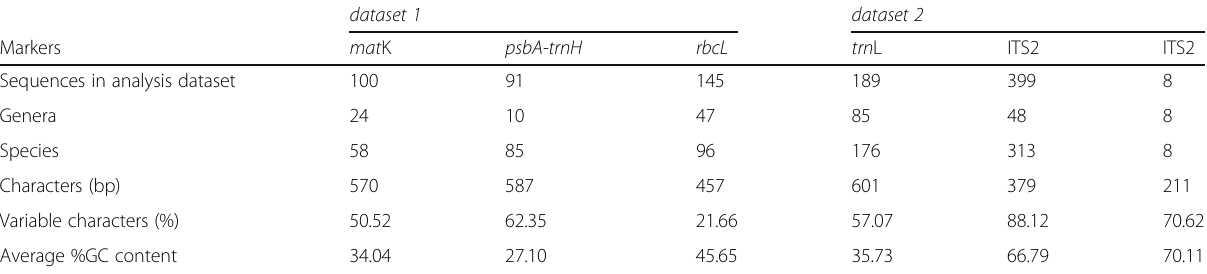
Table 3 Acanthaceae sequences profile of five selected regions ( matK , psbA-trnH , rbcL , trnL and ITS2) in dataset 1 and